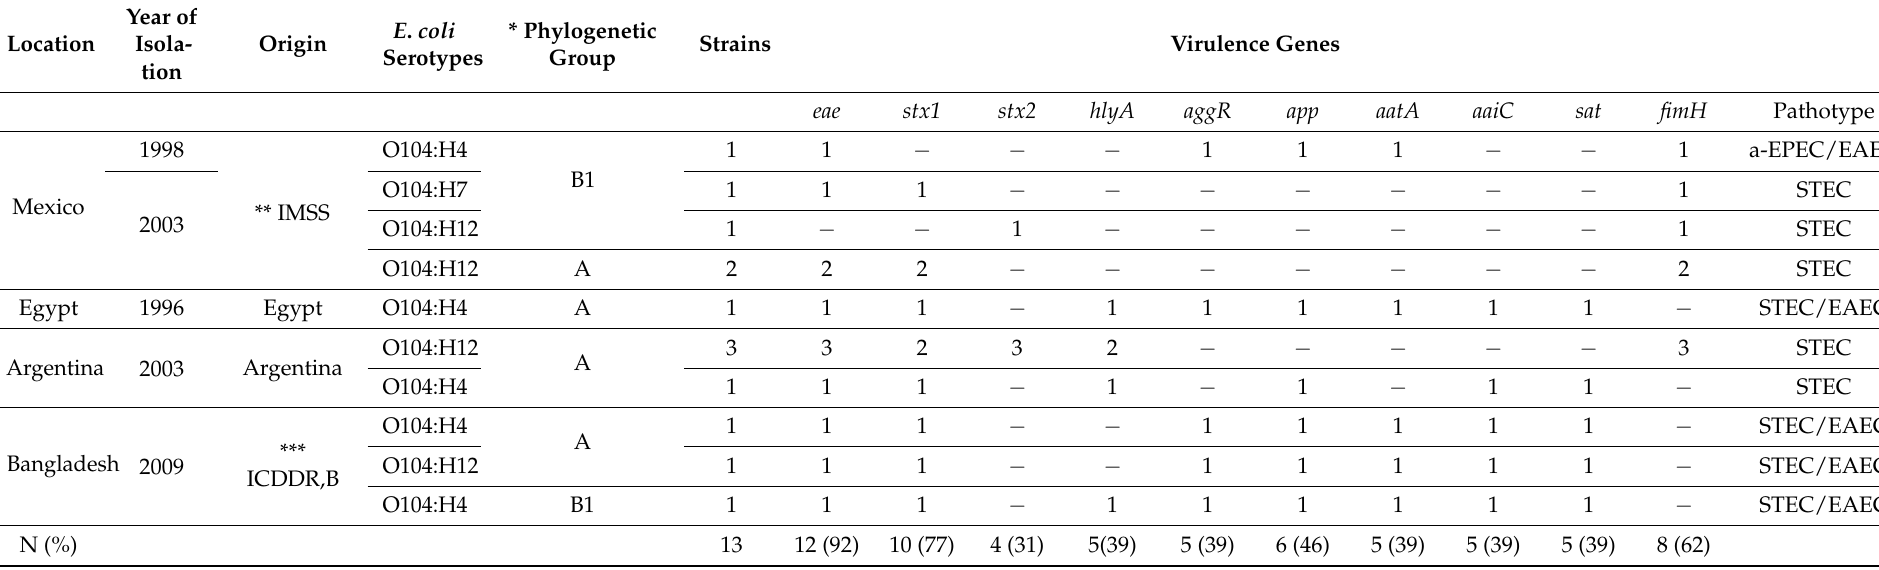
Table 2. Phylogenetic groups and virulence factors in E . coli O104